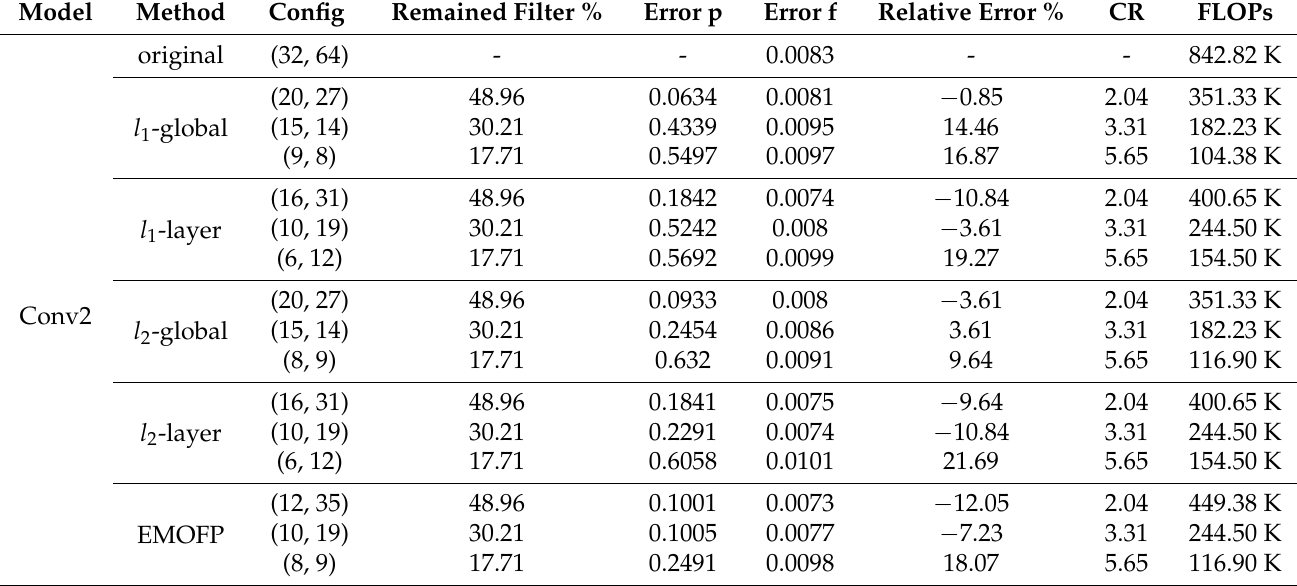
Table 4. Pruning results of Conv2 on